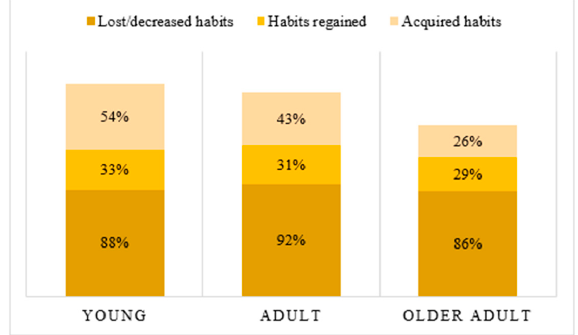
Figure 2. Analysis of age-related change in habits.